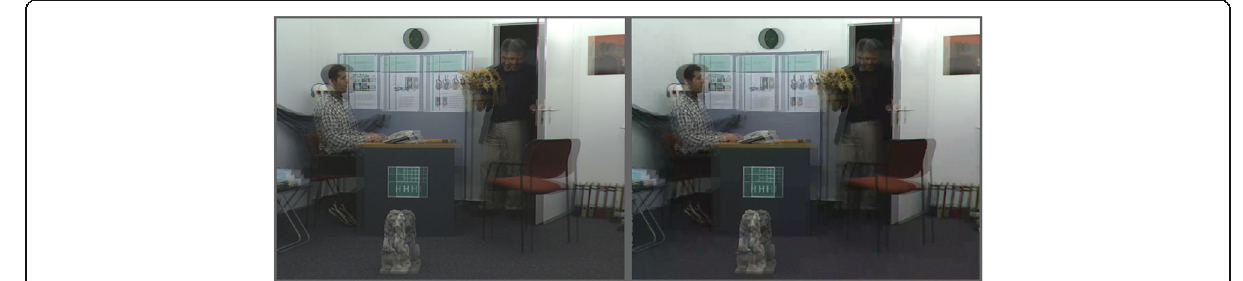
Fig. 7 A comparison clip for the subjective experiment